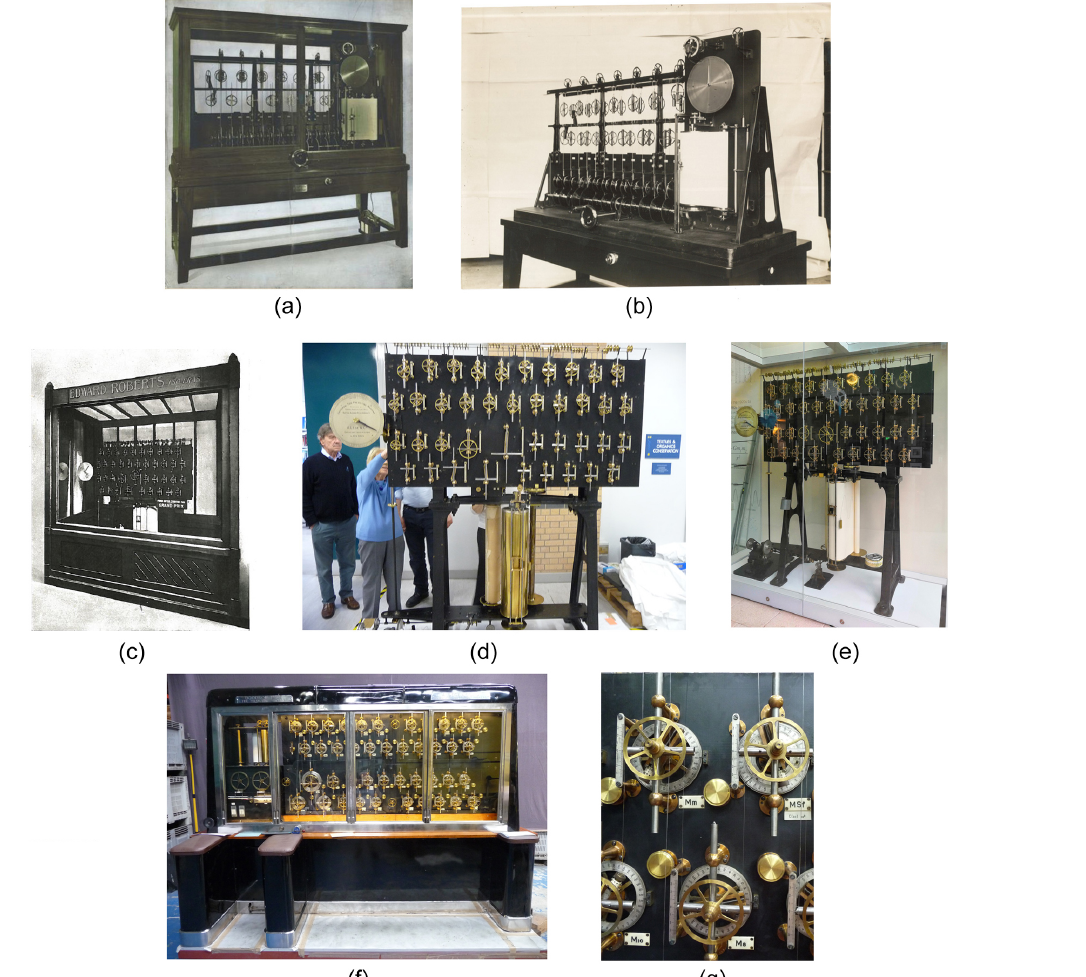
Figure 3. Photographs of the three Bidston TPMs: (a) the Bidston Kelvin Machine as normally seen in its casing and (b) an earlier photograph showing more clearly the machine components, including the wheels for each tidal constituent and, on its right-hand side, the chart plotter. (Photos: National Oceanography Centre and SHOM.) (c) The Roberts–Légé Machine at the Franco–British Exhibition of 1908, (d) being refurbished in 2015 and (e) on display at NOC in Liverpool in 2019. (Photos: National Oceanography Centre, Philip Woodworth and Helen Rawsthorne.) And (f) the Bidston Doodson–Légé Machine after being refurbished in 2015 with (g) a close-up of the pulley wheels for the M10, Mm, M8 and MSf constituents between which a nickel band can be seen passing over or under each pulley. Each amplitude block contains a Vernier screw with which to set the constituent’s amplitude, while its phase is defined using the wheel behind. The brass knobs are the clutch controls for each constituent. (Photos: Philip